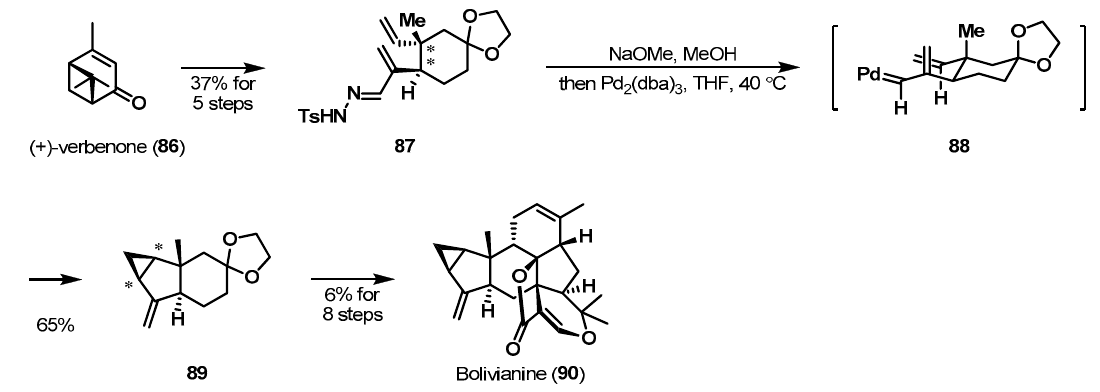
Scheme 13. Total synthesis of bolivianine ( 90 ).